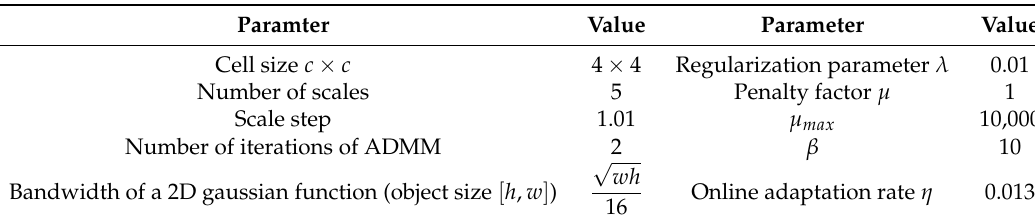
Table 1. Main parameters in the OMFL tracker.